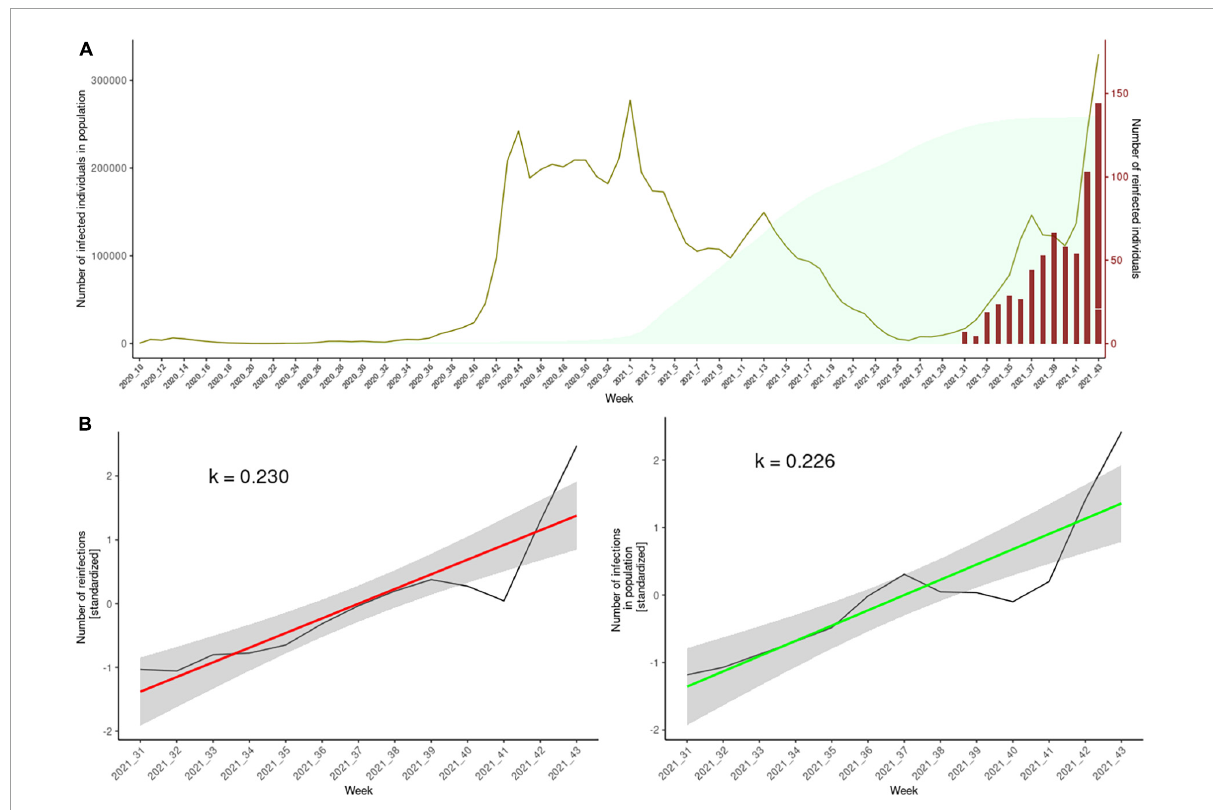
FIGURE1 Panel (A) of this composite plot shows the weekly cumulative total of people eligible for reinfection (light green), the weekly number of positive SARS-CoV-2 tests times 20 (olive), and the number of confirmed reinfections (red). The y-axis on the right side of the plot corresponds to the number of reinfected individuals. The y-axis on the left side corresponds to the number of individuals eligible for reinfection and the number of weekly infections. In order to simultaneously present the two in the same plot, we multiplied the number of weekly infections by 20 (to illustrate, the peak in olive green in the first week of 2021 represent ∼ 15,000 individuals). The cumulative plot, which represents the pool of potential reinfections, is presented with a 90-day lag, according to the ECDC definition criterion for reinfection. Panel (B) depicts the standardized rise of weekly reinfection numbers (red regression line) and the weekly number of positive tests (green regression line).